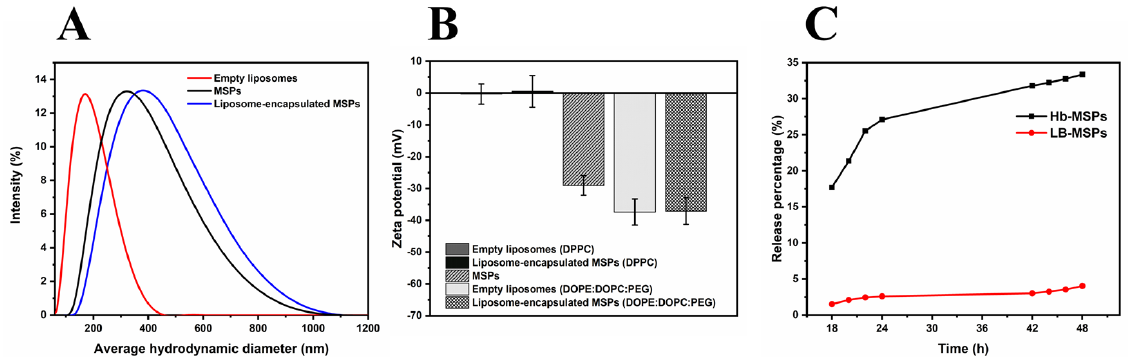
Figure 10. ( A ) Dynamic light scattering for the mean hydrodynamic diameters of empty liposomes, MSPs, and liposome − encapsulated MSPs (LB − MSPs) (in 1 mM phosphate buffer, pH 7.4). ( B ) Zeta potentials before and after MSP encapsulation in the liposomes. The error bars represent the zeta potential data from the streaming potential measurements. ( C ) Release profiles of Hb − loaded MSPs and LB − Hb − MSPs (in phosphate − buffered saline, 37 ◦ C, pH 7.4). The error bars represent the standard deviation.